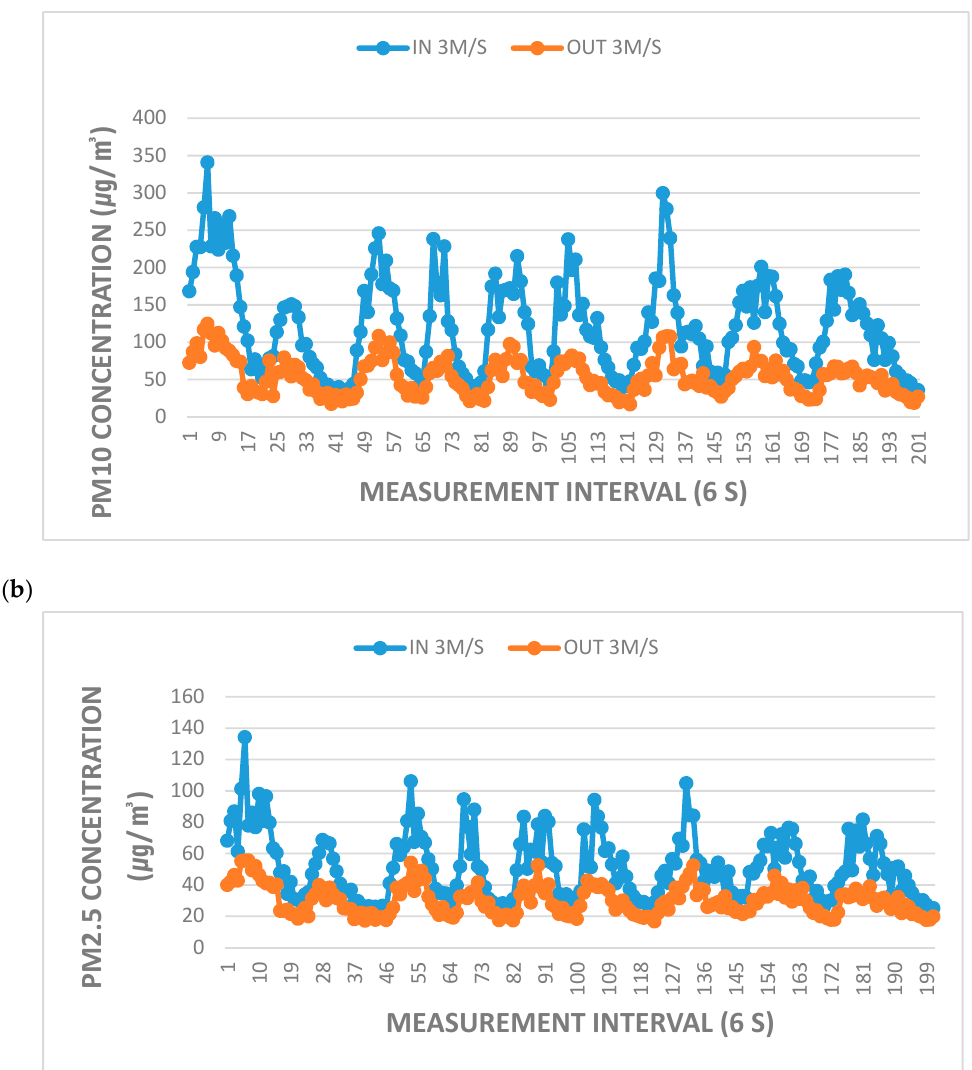
Figure 3. Variation in fine PM removal e ffi ciency under optimal conditions: an ACF depth of 400 mm and flow rate of 3.0 m / s; ( a ) PM 10 ; ( b ) PM 2.5